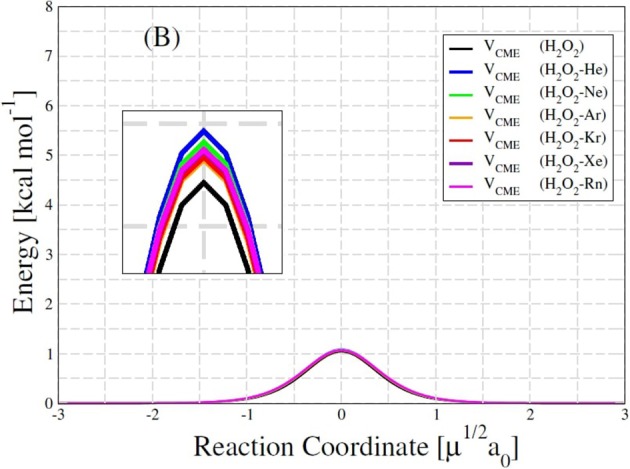
Trans-barrier (B) energies of HP and H2O2-Ng complexes.